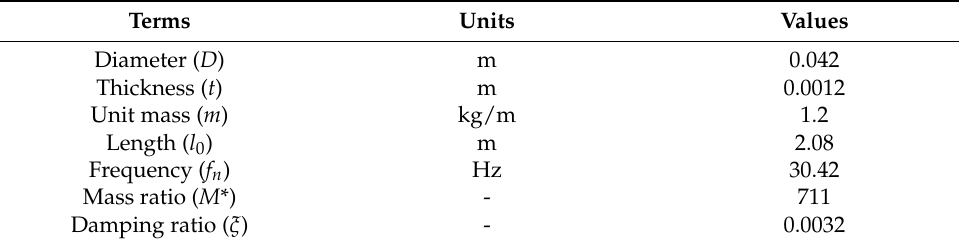
Table 1. Main physical parameters of the test tubes.